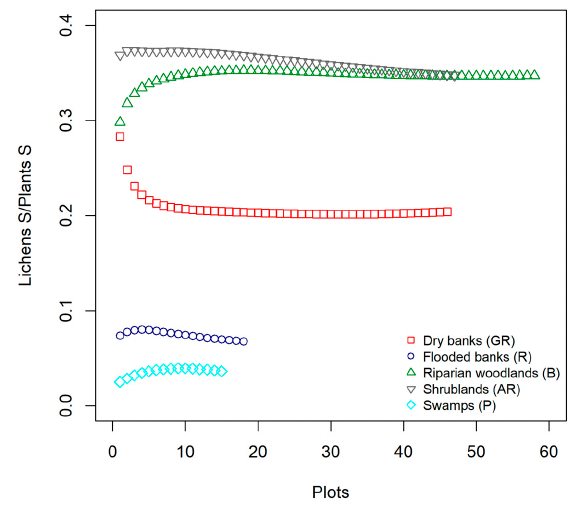
Figure 3. Ratio of lichens and plant rarefaction curves for the whole dataset and for each habitat explored separately.